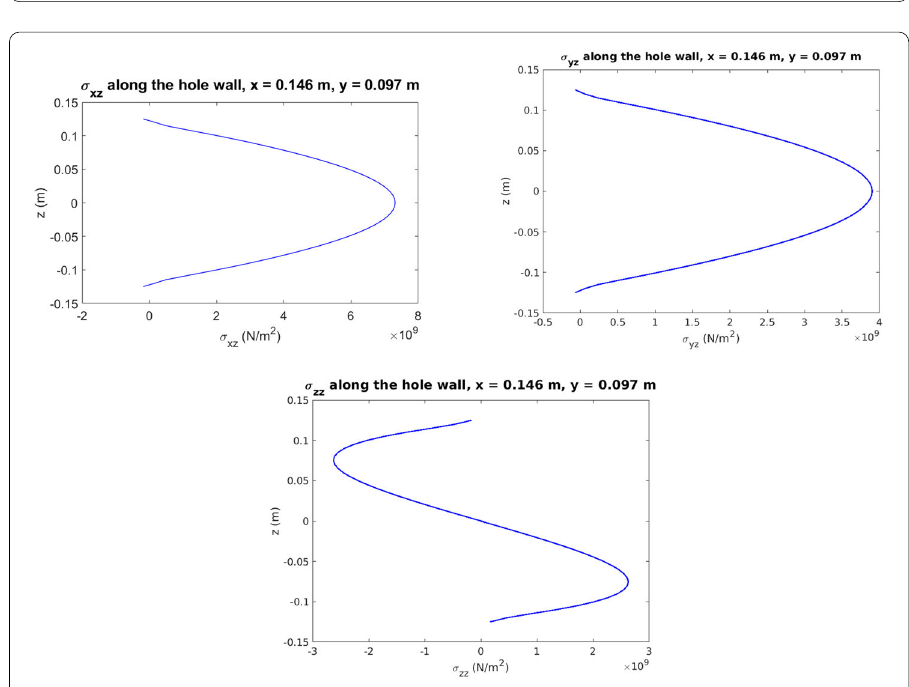
Fig. 10 Out-of-plane stress tensor components around the hole for x = 146 mm and y = 97 mm using 3D